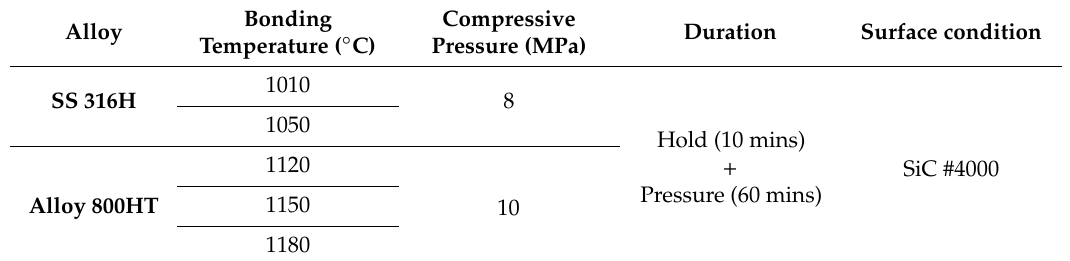
Table 2. Di ff usion bonding